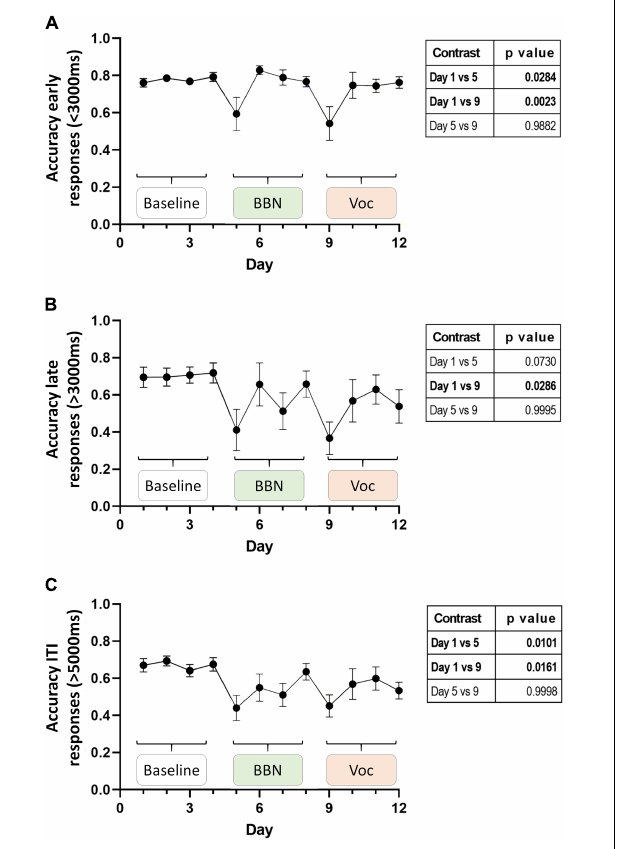
FIGURE 3 | Average accuracy of behavioral responses during the 12-day experimental protocol. Panel (A) shows the average accuracy of the responses from the early time window (0–3 s). In panel (B) the average accuracy of the responses of late time window (between 3 and 5 s), while in panel (C) the average accuracy of the ITI responses (between 5 and 8 s) is shown. Data are displayed as mean ± SEM ( n = 13 chinchillas). Using linear mixed effect models, we found significant effects for behavioral performance on days 5 and 9 (see section “Results” in main text). A table with p -values from the Dunnett multiple comparisons test is shown to the right of each